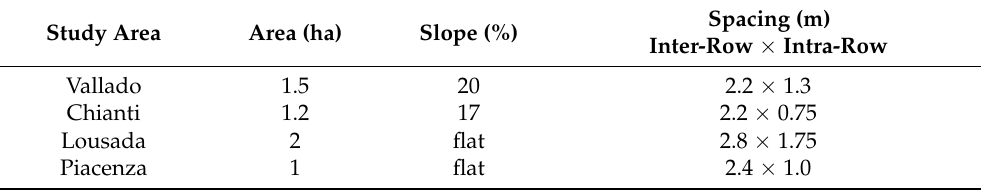
Figure 14. Location of the Italian study areas: ( D ) 1 ha Piacenza vineyard parcel—215 m ASL— belonging to Tenuta La Pernice, Borgonovo Val Tidone, Piacenza, Italy; and ( E ) 1.2 ha Chianti vineyard parcel—355 m ASL—in the Castello di Fonterutoli farm, Castellina in Chianti, Siena, Italy. Images from Google Earth (accessed on 18 December 2020). Table 4. Comparison between study areas’ structure, dimension, and orography. Both the Portuguese and Italian study areas have a flat and a more rugged terrain, with comparable dimensions and vineyard structure.